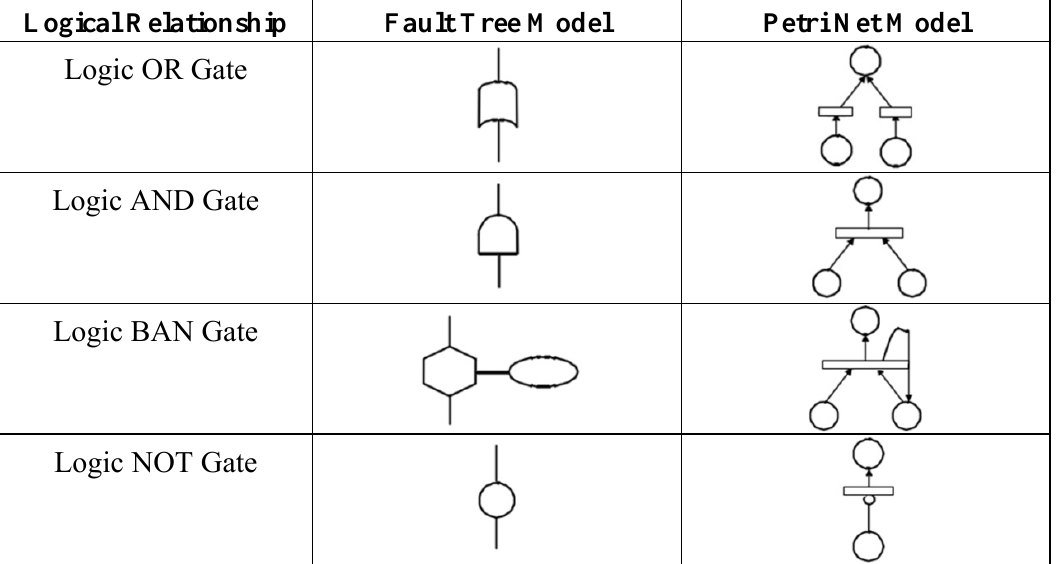
Table 1. Logic representation of fault tree and corresponding fault Petri